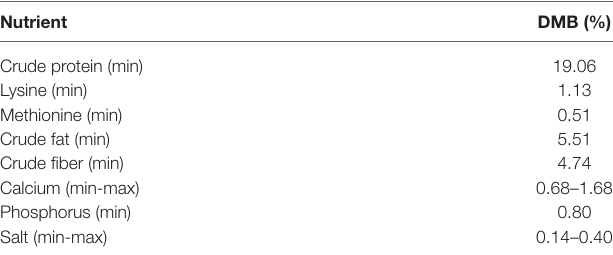
FIGURE 1 | Experimental layout. At 16 days of age, the chickens were sorted by breed (Cornish cross or Red ranger) into repeated groups of either treatment (pasture with hedges) or control (pasture without hedges), for a total of eight populations of 20 chickens each. Each chicken was banded for individual identification and sex was randomly assorted across the populations. TABLE 1 | Starting at 16 days of age, the chickens were fed Mosaic Oregon Non-GMO Grower/Broiler Formula chicken feed, a balanced commercial pelleted